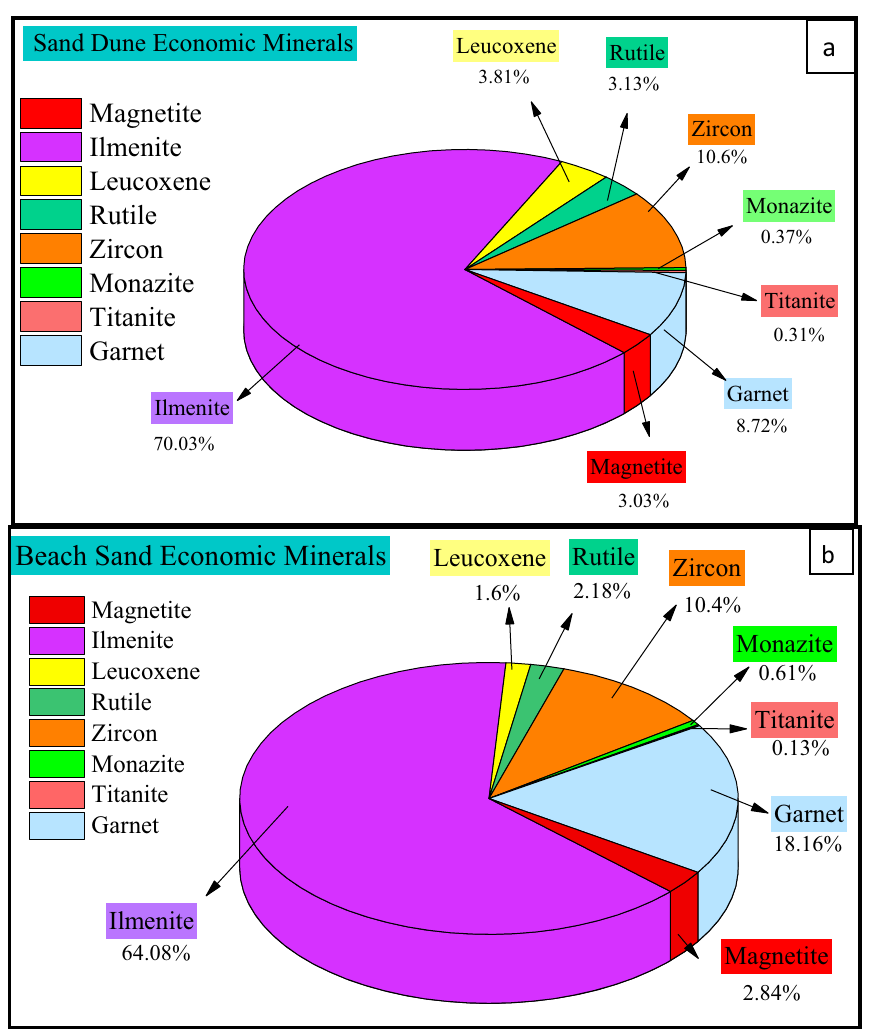
Figure 7. Pie diagram illustrates the frequency % of each individual heavy mineral relative to total economic heavy minerals (TEHM) for ( a ) sand dune and ( b ) beach